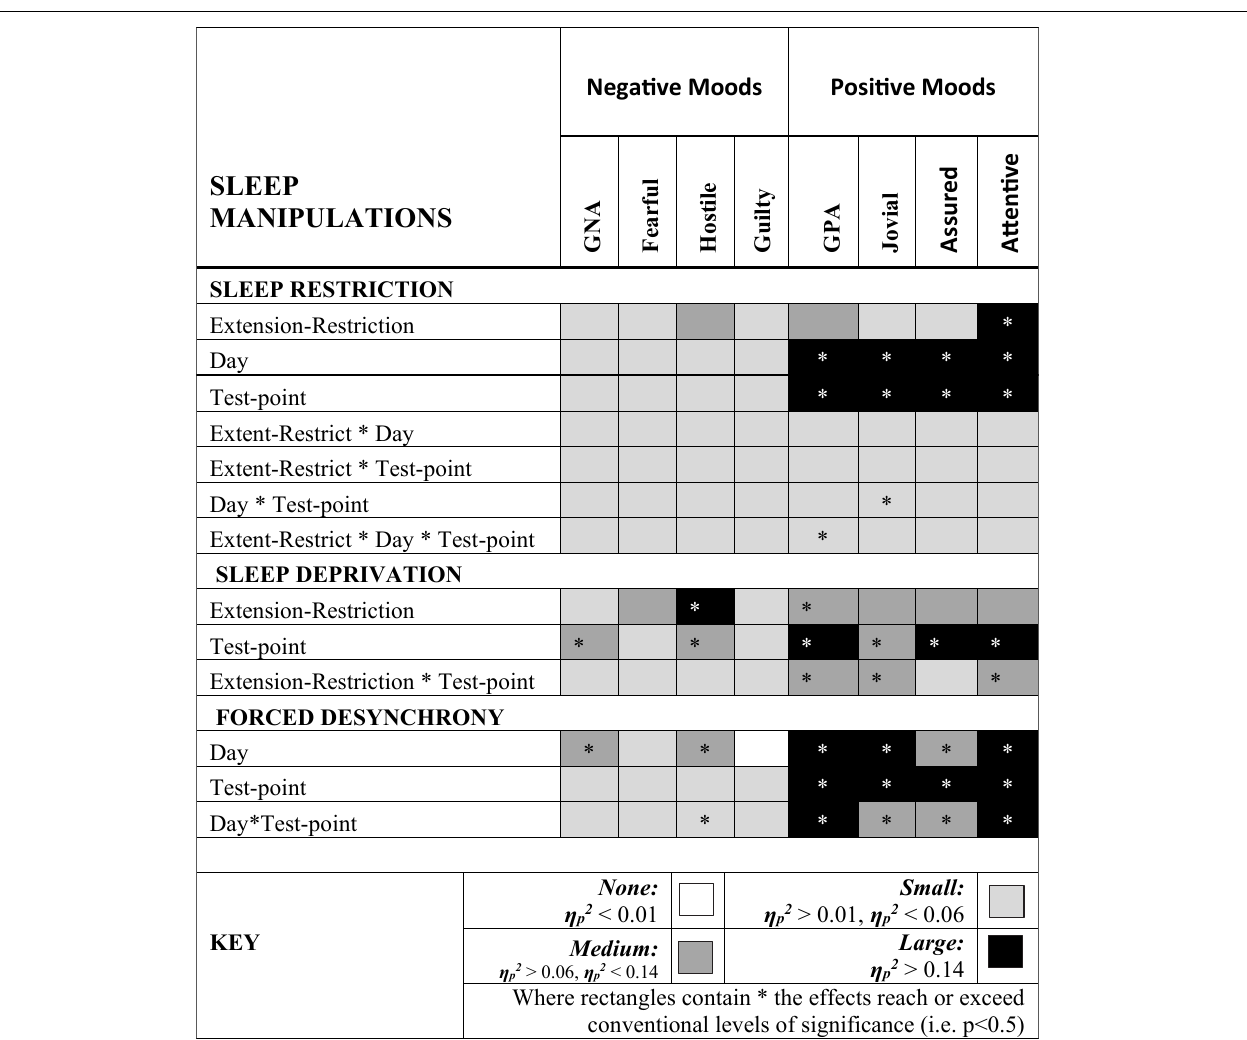
FIGURE 9 | Effect sizes of sleep manipulations on Negative and Positive moods. Where rectangles contain * the effects reach or exceed conventional levels of significance (i.e. p <